Question: Provide a one-line summary of what is displayed.
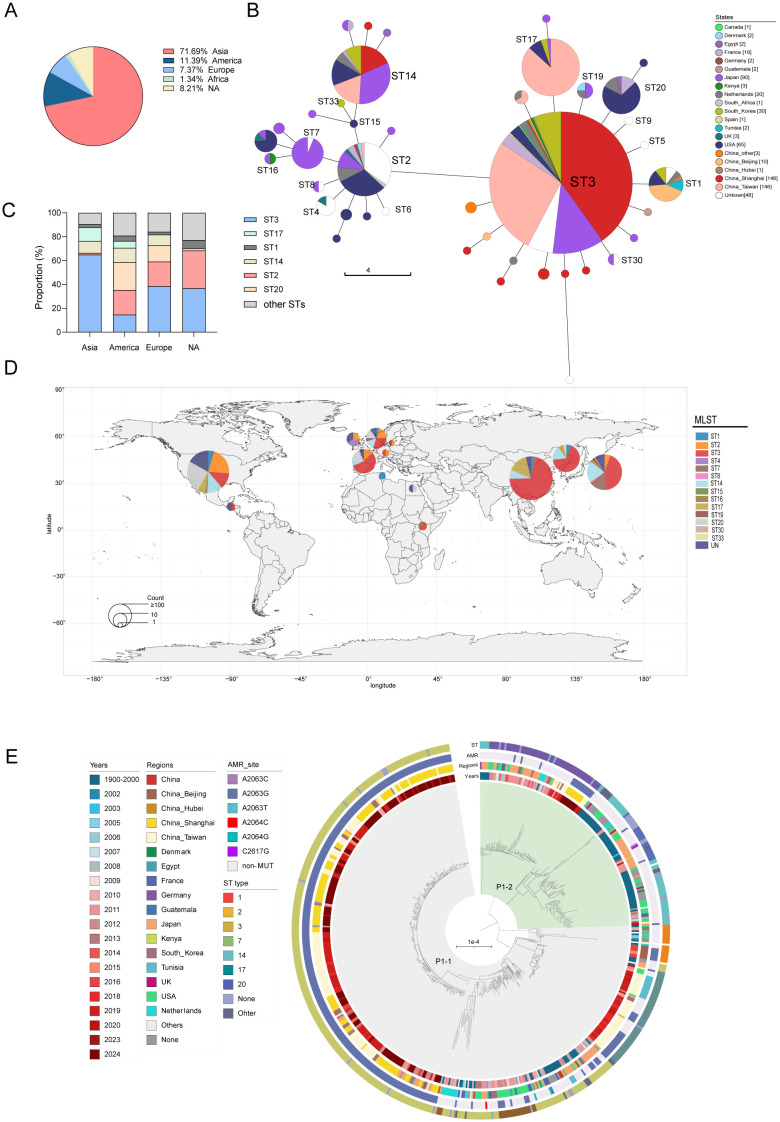
Answer: Population structure and geographical distribution of Mycoplasma pneumoniae sequence types. (A) Combined dataset of 597 M. pneumoniae genomes across different continents. NA, not assigned. (B) The minimum spanning tree of the 597 M. pneumoniae genomes based on STs. Each circle represents a unique ST type and the circle size is proportional to the number of isolates. Colors represent geographical regions. Samples from the current study are marked in red. (C) Prevalence of major STs across different continents. (D) Geographical distribution of ST types among 597 isolates (including 148 from this study). Pie charts depict the ST composition per region, with chart size proportional to the number of isolates. (E) Phylogenetic tree of the 148 M. pneumoniae isolates. Metadata for isolation year, geographical region, antimicrobial resistance (AMR) genes, and ST types were coded in the outside rings by colors.